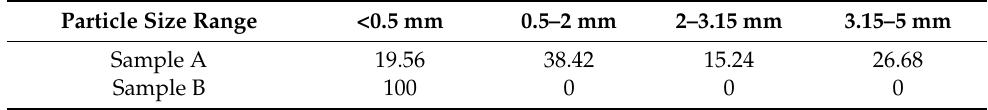
Table 1. Particle size distribution of samples A and B